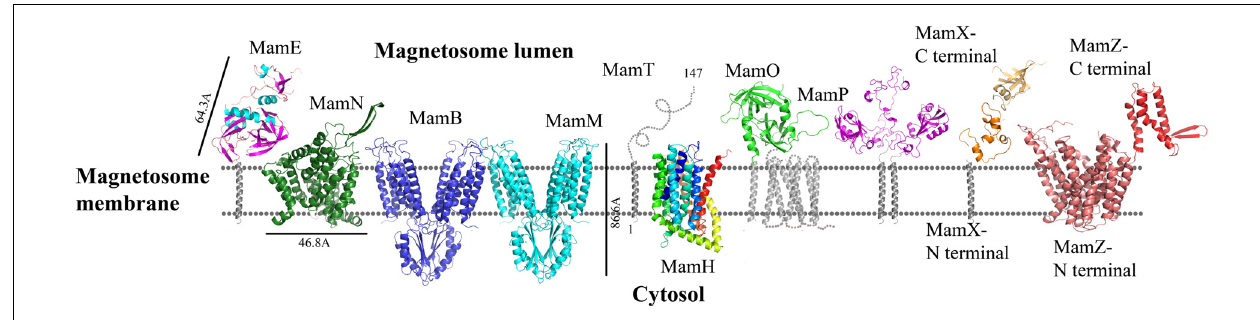
FIGURE 3 | Protein structure predictions that are involved in iron transport and nucleation. Structures are in ribbon representation. Predictions of anchoring transmembrane helices are in gray. Black bars define the protein size in angstroms. Magnetotactic ovoidal bacterium MO-1 MamP structure was determent by X-ray